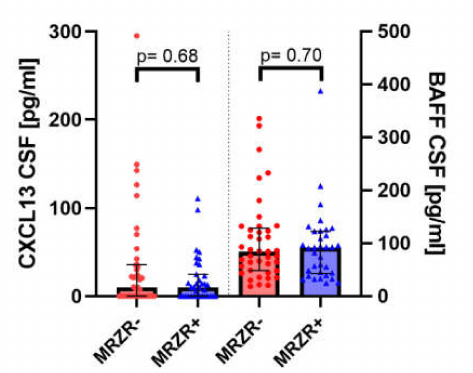
CAML interactor. Detection rates of all parameters did not di ff er significantly between MRZR + and MRZR- patients.